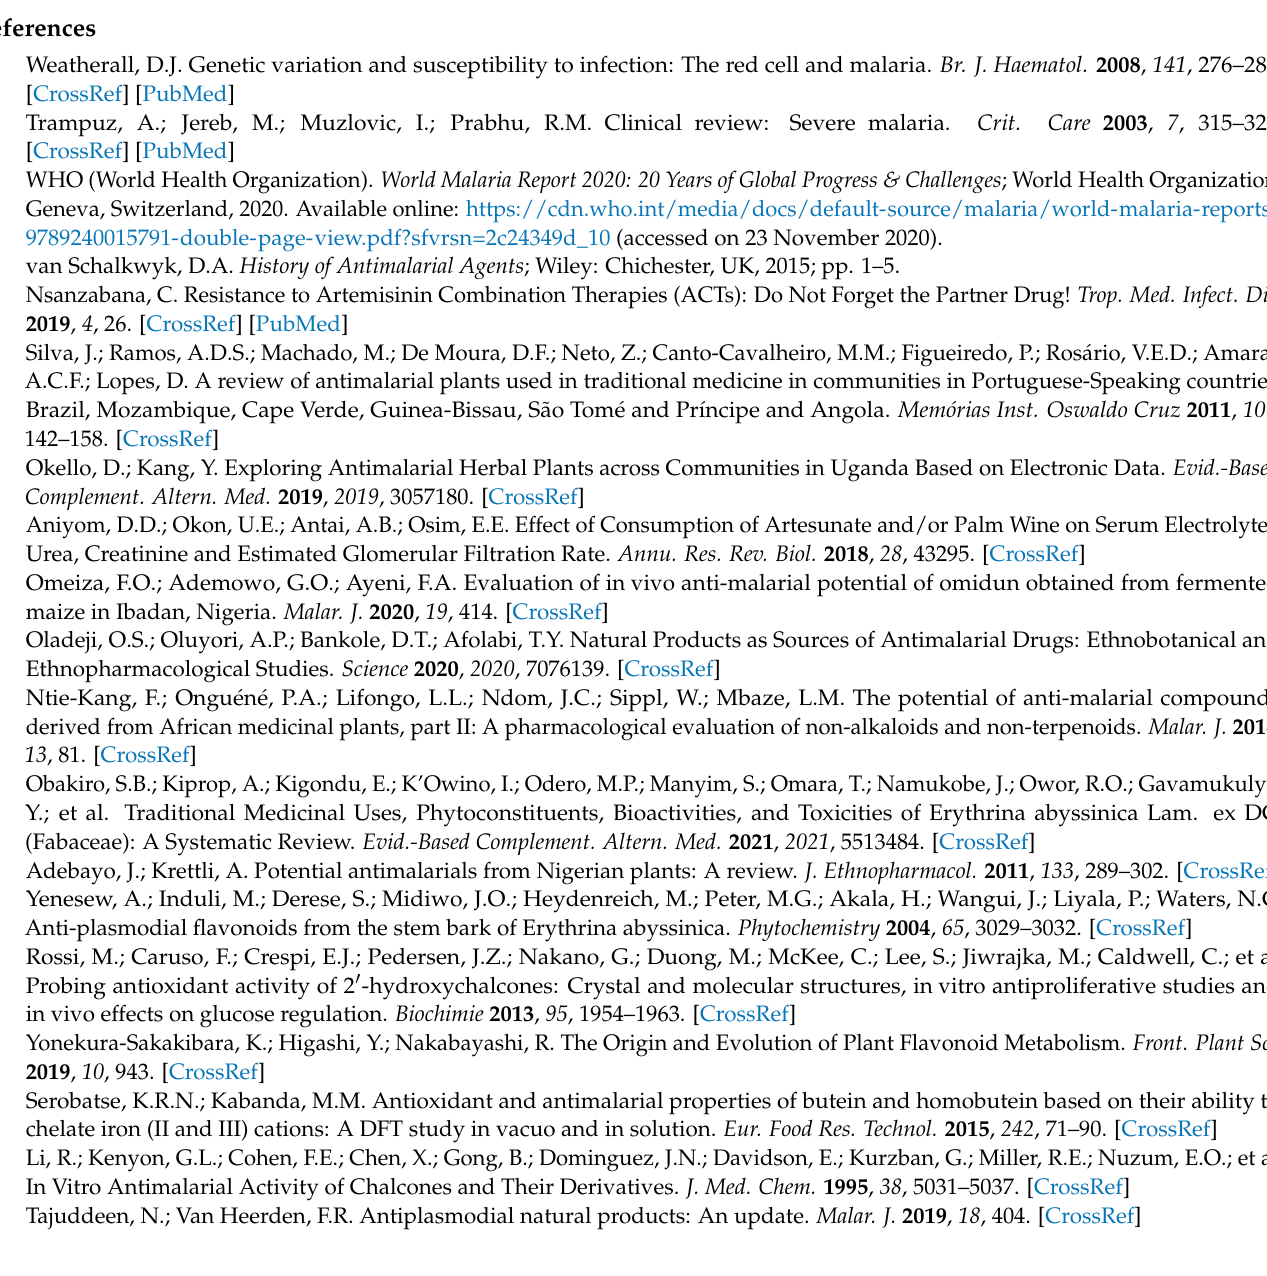
1.478 Å). Figure S7: 2D interactions between DHDM (2) pose 2 and the active site of Falcipain-2, after calculating bonding energy. Figure S8: 2D interactions between docked pose 3 of 5-Prenylbutein and the active site of Falcipain-2. Table S1: Comparison between bond distances in the crystal and DFT